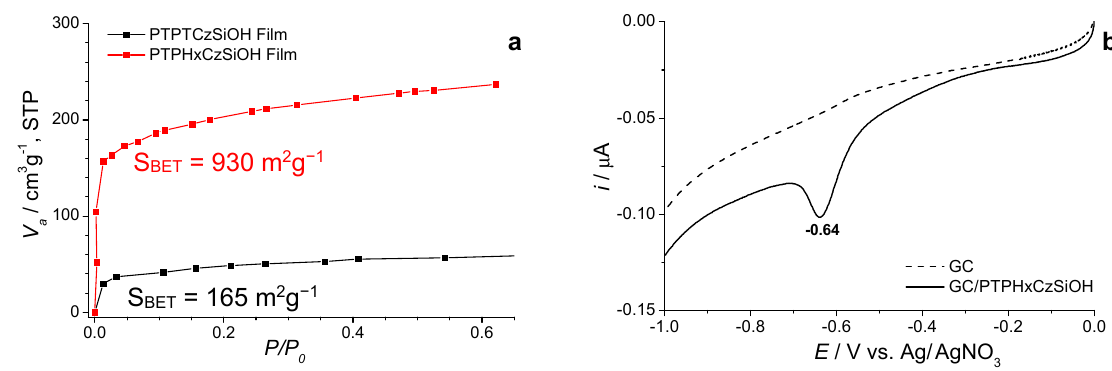
Figure 6. ( a ) Adsorption isotherms of electrochemically produced polymer films using krypton gas. Specific surface areas were obtained by applying the Brunauer − Emmett − Teller (BET) equation to the krypton gas adsorption isotherms (mean value of three measurements). ( b ) Linear scan voltammograms for the detection of 0.5 µ M nitrobenzene at bare (dashed line) and PTPHxCzSiOH-modified (solid line) glassy carbon electrodes in aqueous, bu ff ered solutions. These voltammograms were recorded with a sweep rate of 0.01 V s − 1 .